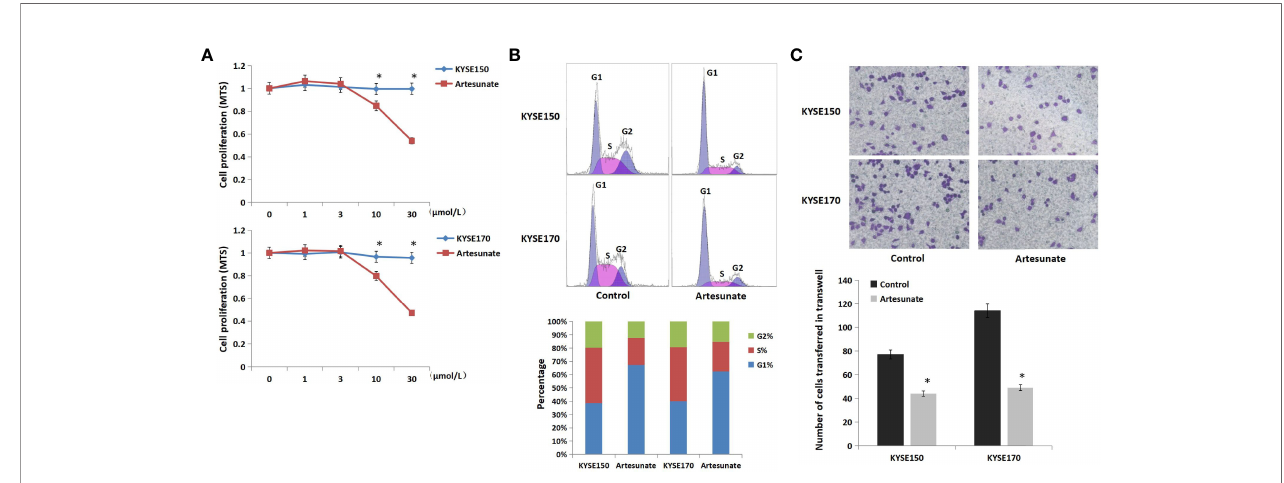
FIGURE 1 | The role of artesunate in EC cells. (A) The effect of artesunate on the viability of EC cells by MTS. (B) The effect of artesunate on the cell cycle of EC cells by fl ow cytometry. (C) The effect of artesunate on the metastasis of EC cells by Transwell assays. *P <